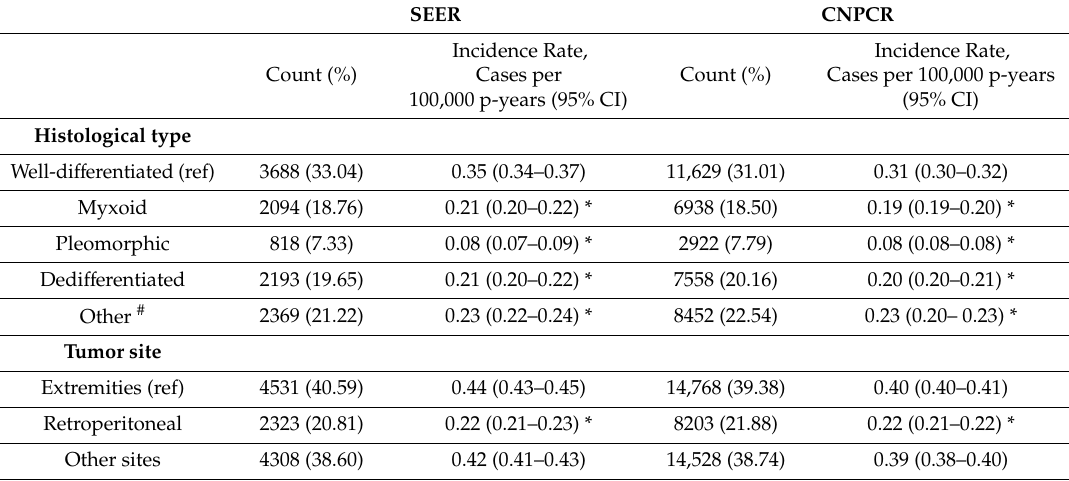
Table 2. Liposarcoma cases and age-adjusted incidence rates by tumor histology and site,